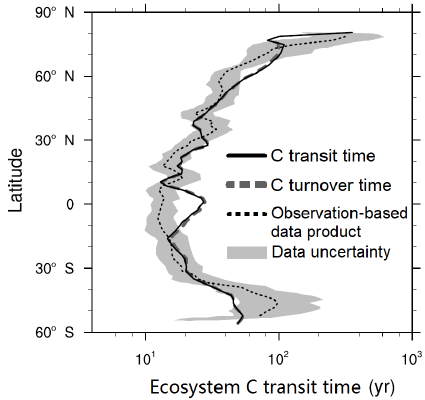
Figure 2. Validation of simulated latitudinal variation pattern in ecosystem C transit time. Comparison of the mean ecosystem C transit time from 1982 to 2005 as estimated in this study with the estimates from observation (Carvalhais et al., 2014) and simulated C turnover time from CABLE. The grey area indicates the uncer- tainty range of observation-based data. C transit time theoretically equals C turnover time only at steady state. To ensure the compar- ison is valid, we assumed, which is also assumed by some other ecological studies (Trumbore, 2000), that ecosystem C cycle dur- ing the data-covered period (1982 to 2005) is closed to the steady state. In addition, the global C balance data also support our as- sumption. In the 1980s and 1990s, global land C uptake from the Global Carbon Project (GCP) is about 0.8GtCyr − 1 with an uncer- tainty of 0.6GtCyr − 1 , which is not significantly different from zero (Le Quéré et al.,